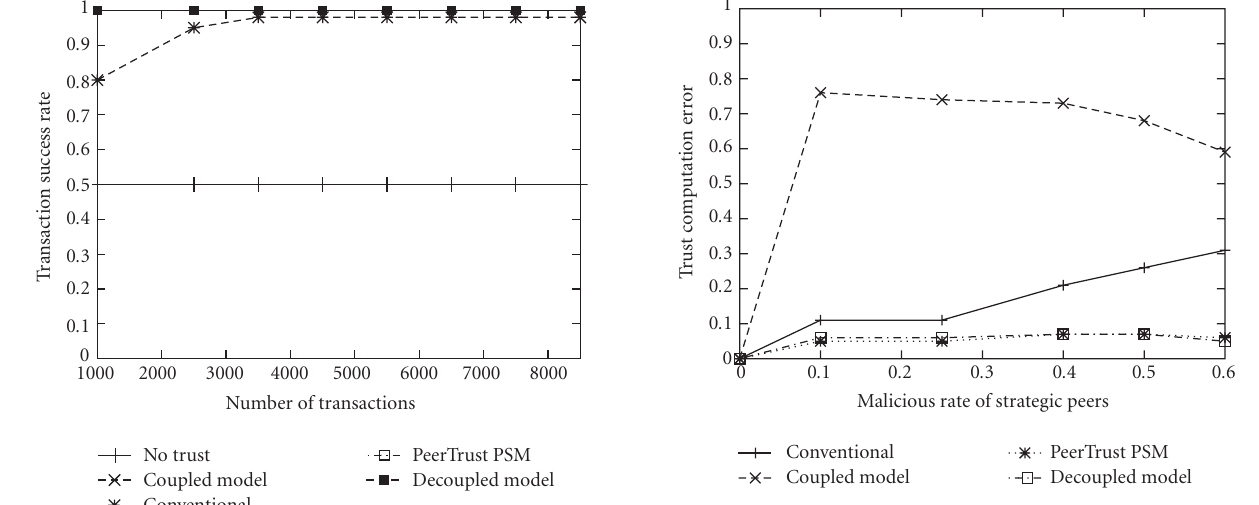
Figure 2: The benefit of a trust-based peer selection scheme.